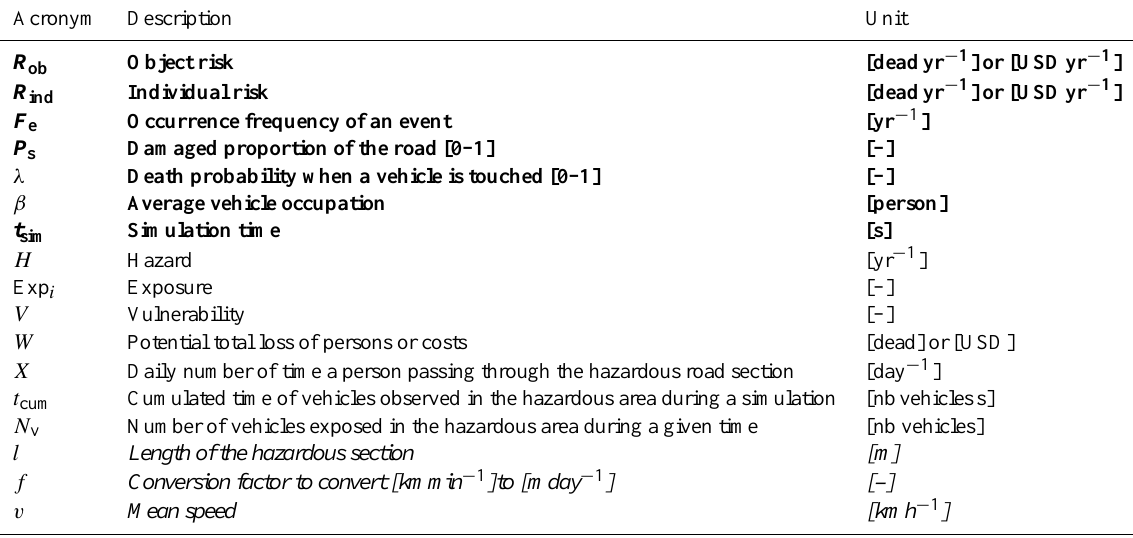
Table 1. Parameters used to assess risk from natural hazards on roads. Bold: output results and input parameters needed to solve the kine- matics object risk equation. Normal: intermediary parameters solved during the calculation by the simulator. Italic: used only in